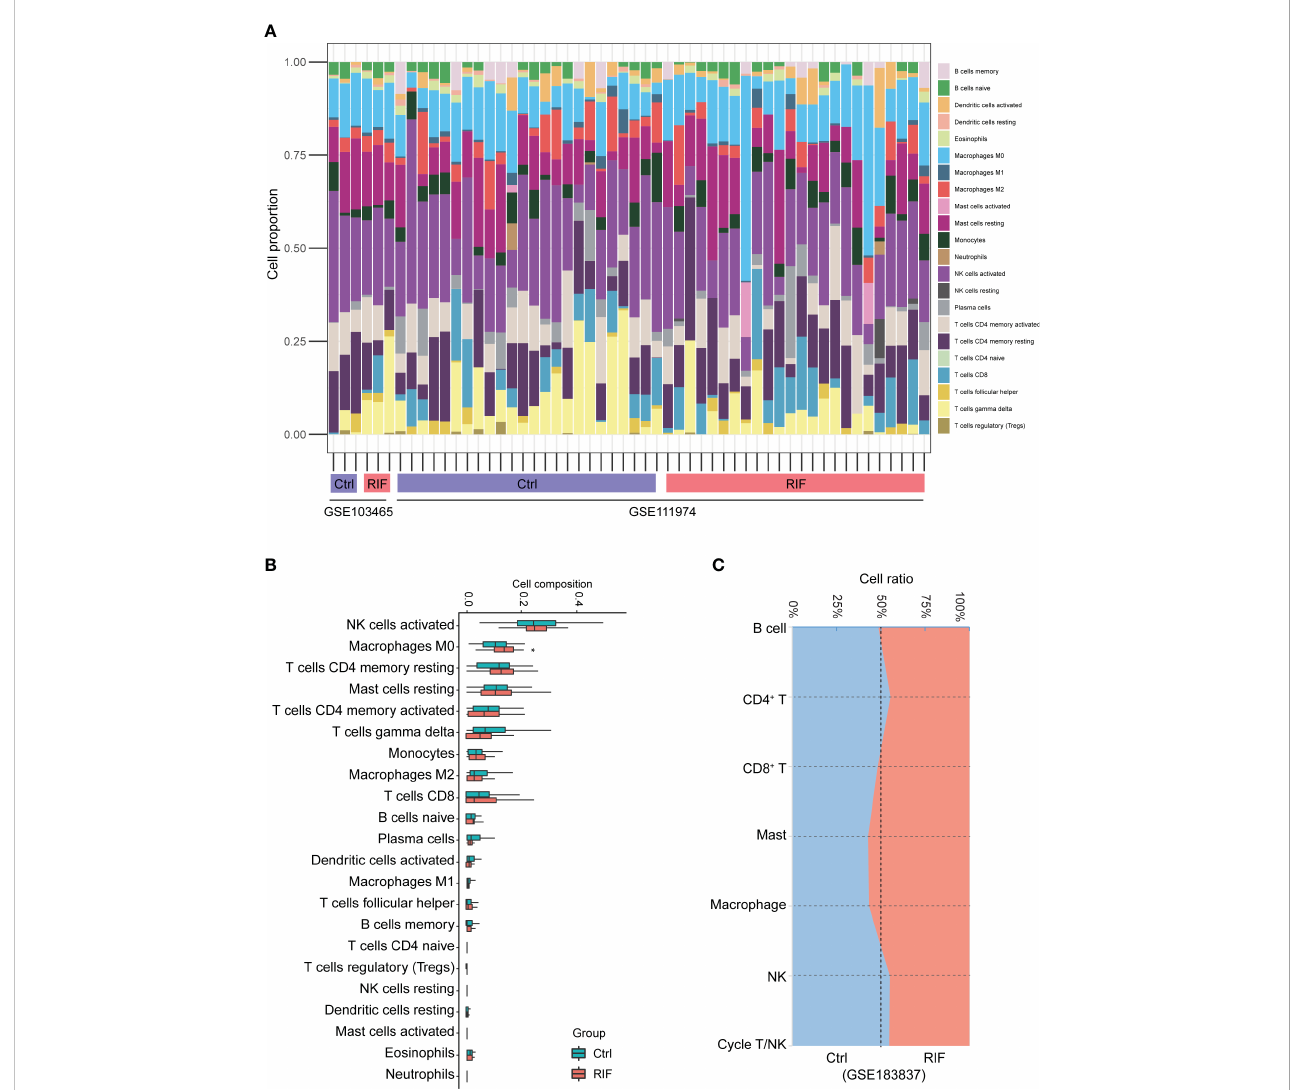
FIGURE 5 The landscape of immune in fi ltration between RIF and control samples. (A) The relative percentage of 22 types of immune cells. (B) The difference of immune in fi ltration between RIF and controls. The control group was marked as blue color and RIF group was marked as red color. (C) Stacked area plot showed the relative percentage of 7 types of immune cells from validation dataset (GSE183837). Data are presented as the median and the interquartile range. Statistical signi fi cance (Kruskal – Wallis test with Dunn ’ s multiple-comparison test): *p <